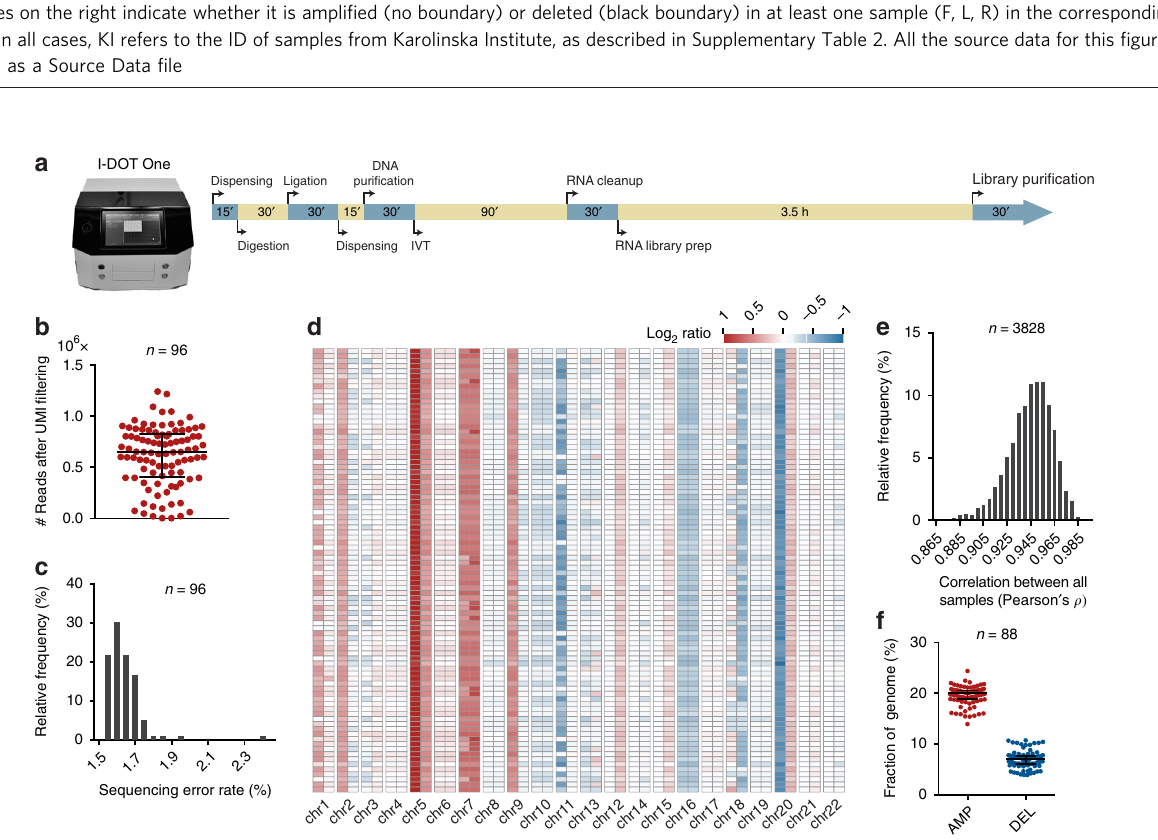
Fig. 3 Multi-region copy number pro fi ling in FFPE breast cancer tissue sections. a Scheme of regions within individual FFPE breast cancer sections from which gDNA was extracted. S, small regions of ~3 mm 2 . L, large regions of ~7 mm 2 . For each L region, gDNA was split in two technical replicates, L1 and L2. F, remaining tissue in the section. b Scans (×10 magni fi cation) of 35 hematoxylin – eosin-stained tissue sections from primary (T) and metastatic (M) breast cancers, and corresponding copy number pro fi les (100 kb resolution), for F, L, and S regions. Black circles: L region from which L1 and L2 replicates were obtained. Black arrowheads: ampli fi cation of the RAD51B gene in patient KI2 and of the HER2 gene in patient KI7. In all the pro fi les, chr1 is on the left and chr22 on the right. c Pearson ’ s correlation ( ρ ) between the fraction of the genome either ampli fi ed or deleted in all the L1 – L2 replicates shown in b . d Hierarchical clustering of copy number pro fi les for F, L, and R regions, in patient KI13. e Same as d , but for patient KI14. f Ranking of 712 cancer- associated genes in COSMIC 15 based on the number of samples in which they were found ampli fi ed (AMP). Gene names refer to a subset of 31 COSMIC genes that were found to be frequently ampli fi ed or deleted in 560 breast cancers 16 . g Same as f , but for genes deleted (DEL) in the samples shown in b . h Hierarchical clustering of 712 COSMIC genes (rows) based on their ampli fi cation (red) or deletion (blue) status in the 133 samples shown in b (columns). Gene names indicate 14 out of 31 genes that were previously found to be either ampli fi ed or deleted in breast cancer 16 . For each gene, the rectangles on the right indicate whether it is ampli fi ed (no boundary) or deleted (black boundary) in at least one sample (F, L, R) in the corresponding KI patient. In all cases, KI refers to the ID of samples from Karolinska Institute, as described in Supplementary Table 2. All the source data for this fi gure are